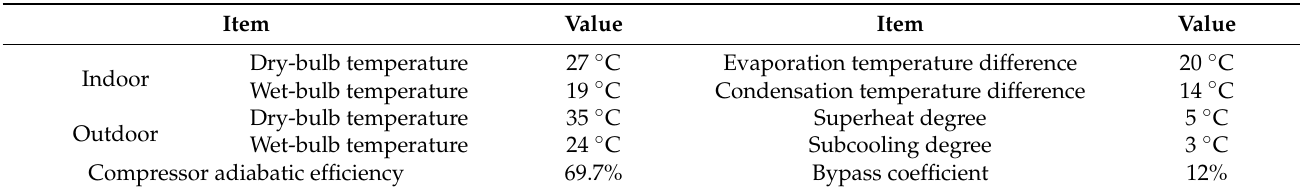
Table 1. Input conditions for cycle analysis.